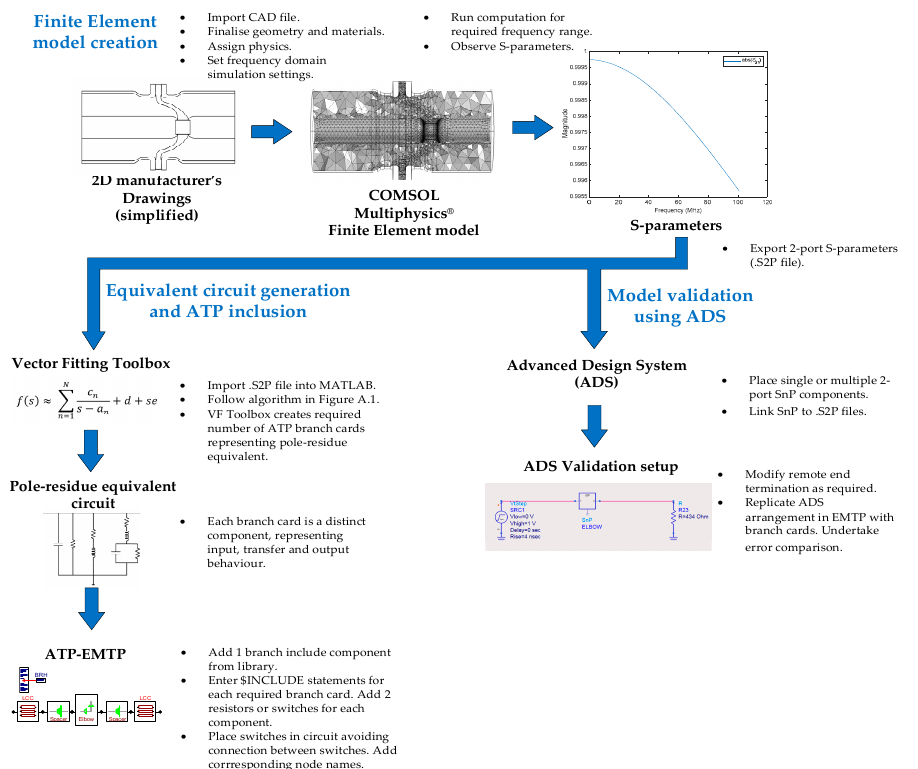
Figure 6. Vector fitting (VF) modelling workflow and method validation using advanced design system (ADS).